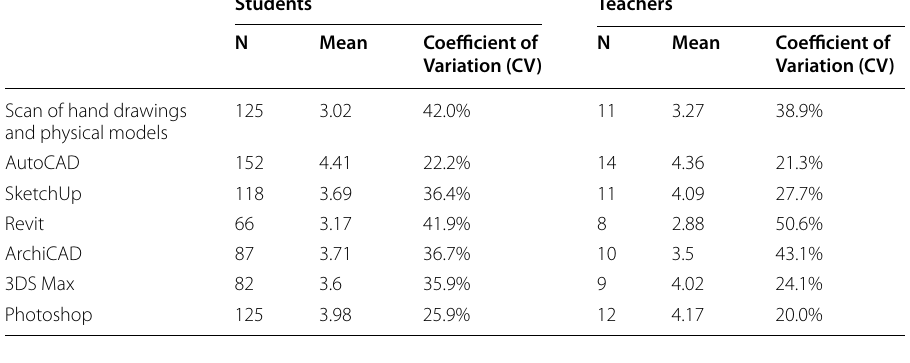
Table 2 The effectiveness of digital presentation tools in the studio